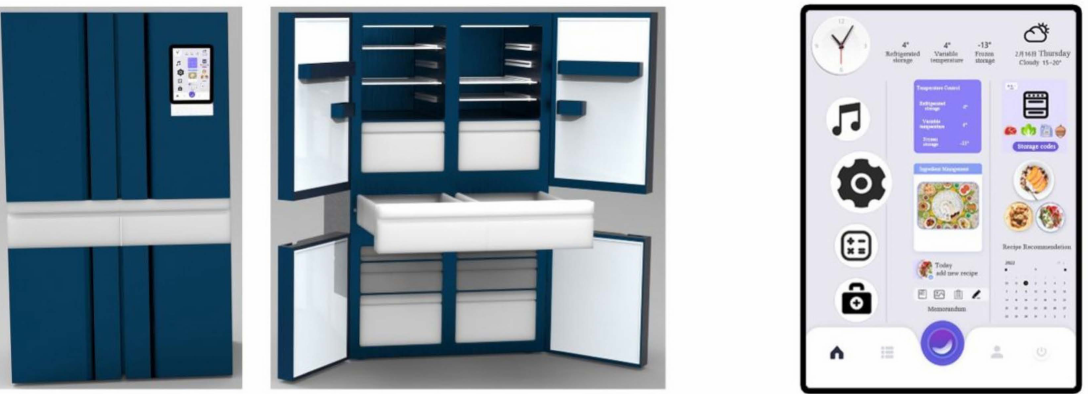
Figure 7. Scheme (D): Product and interaction